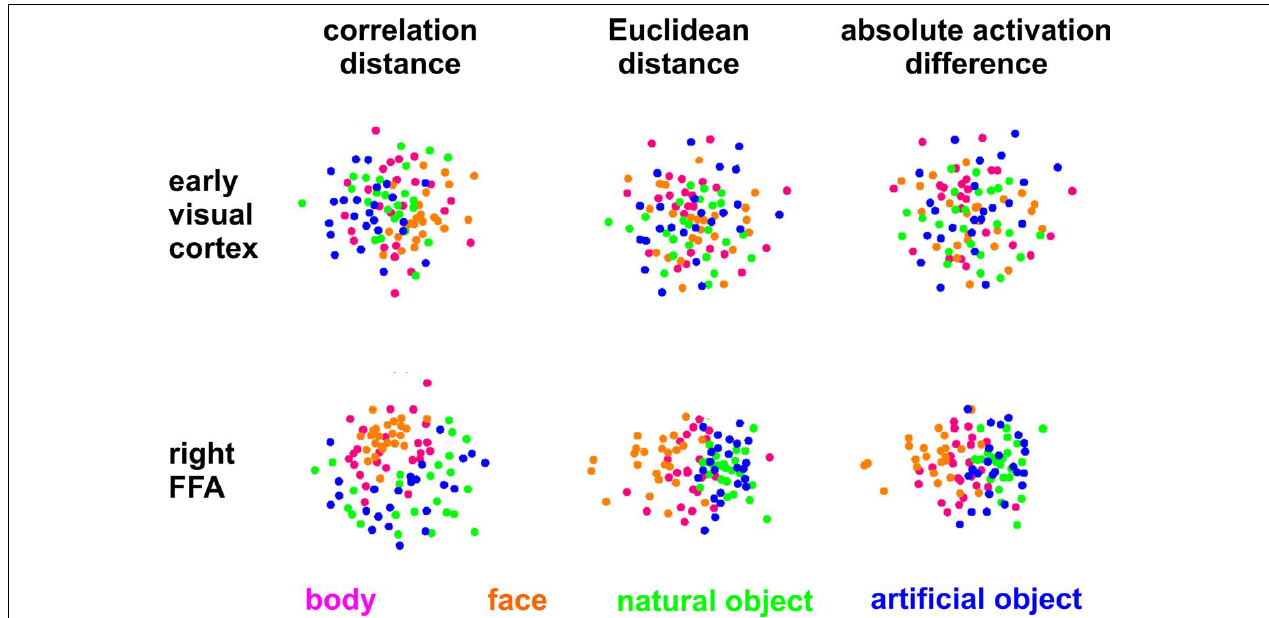
FIGURE 4 | Unsupervised arrangement of 96 experimental conditions refl ecting pairwise activity-pattern similarity . As in Figure 1 , but for 96 instead of 4 conditions, the arrangements refl ect the activity-pattern similarity structure. Each panel visualizes the RDM from the corresponding panel in Figure 10 . Each condition (corresponding to the presentation of one of 96 object images) is represented by a colored dot, where the color codes for the category (legend at the bottom). In each panel, dots placed close together indicate that the two conditions were associated with similar activity patterns. Dots placed are not meant to resemble neurons in the primate visual